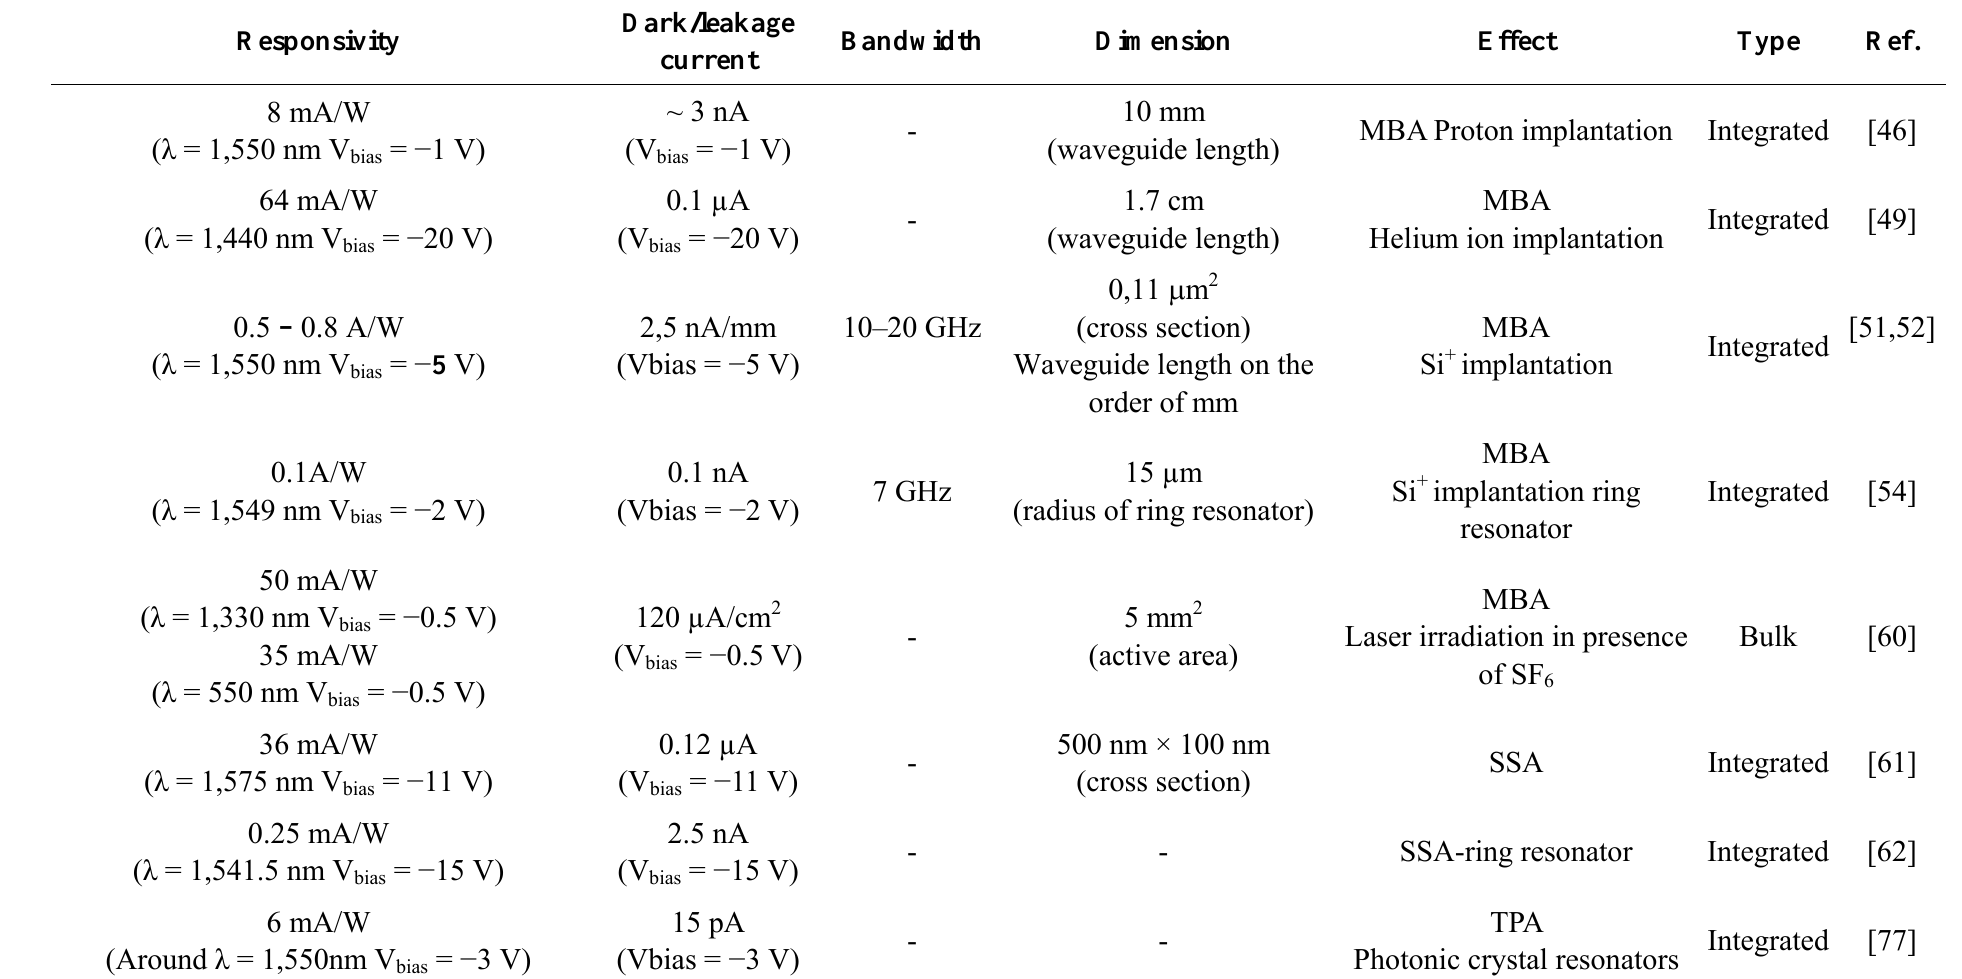
Table 1. Performance summarization of NIR all-silicon photodetectors reported in the literature. Dark/leakage Responsivity Dimension Effect Type